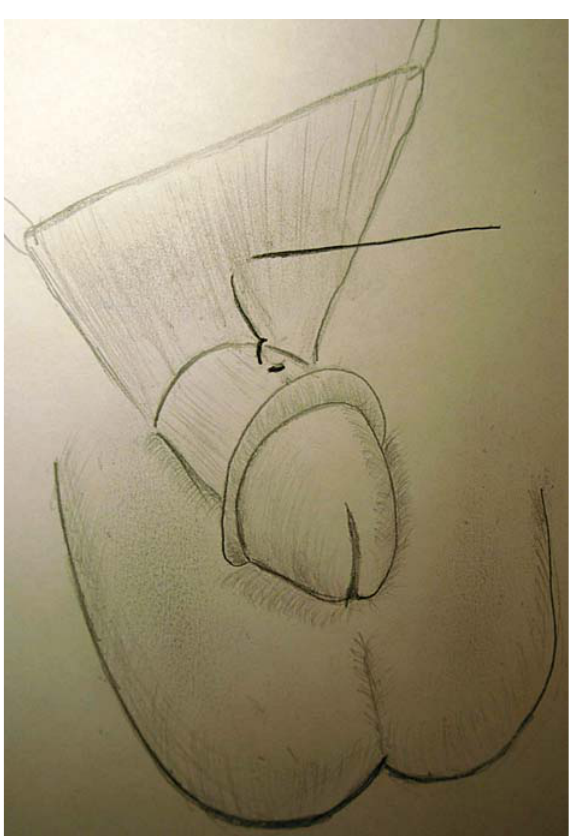
Figure 7 – Stitches incorporate the foreskin to the penile